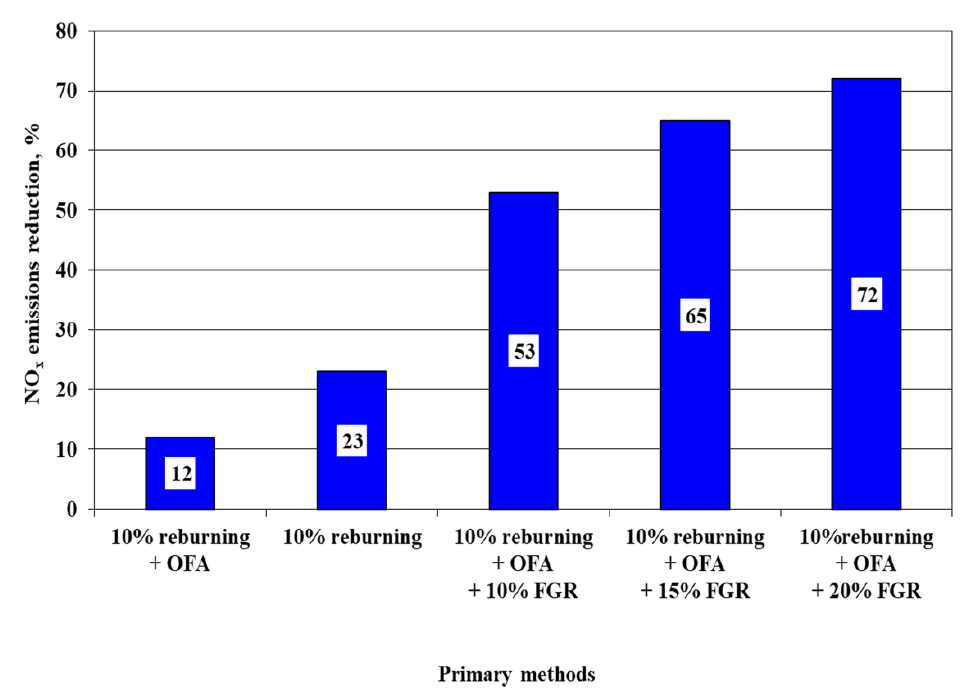
Figure 7. NO x emissions reduction achieved after application of primary methods and their combinations at total fuel input Q = 1.8 m 3 / h and air excess coe ffi cient m =